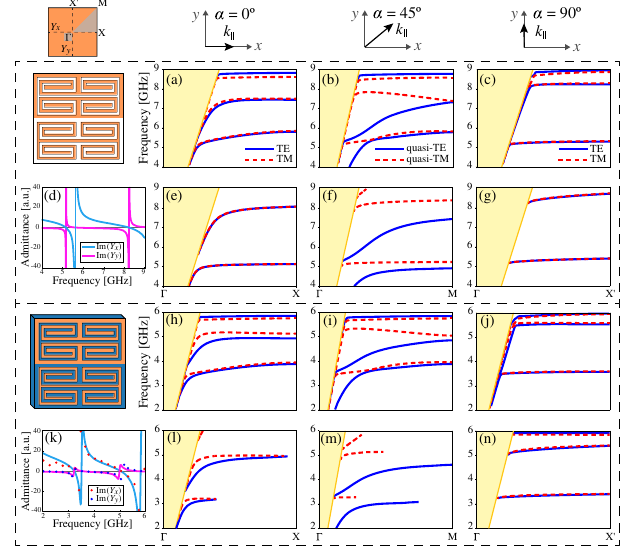
FIG. 6. Dispersion diagrams for surface waves localized at the self-complementary metasurface, shown in Fig. 5, without a substrate (a) – (g) and with a substrate (h) – (n) for different propagation angles α ¼ 0 ° (a,e,h,l), α ¼ 45 ° (b,f,i,m), and α ¼ 90 ° (c,g,j,n). The TE (blue solid line) and TM (red dashed line) dispersion curves were calculated numerically with the CST eigenmode solver [(a) – (c), (h) – (j)] and analytically [Eq. (10)] [(e) – (g), (l)-(-n)] by using the numerically (d,k) and experimen- tally [color dots in (k)] recovered effective surface admittance